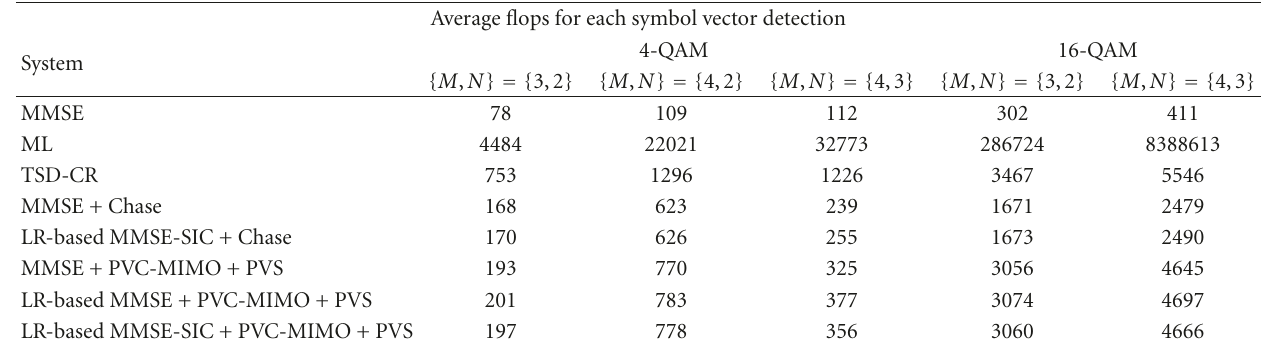
Table 2: Complexity comparison of di ff erent detectors listed in Section 5.1. Average flops for each symbol vector detection